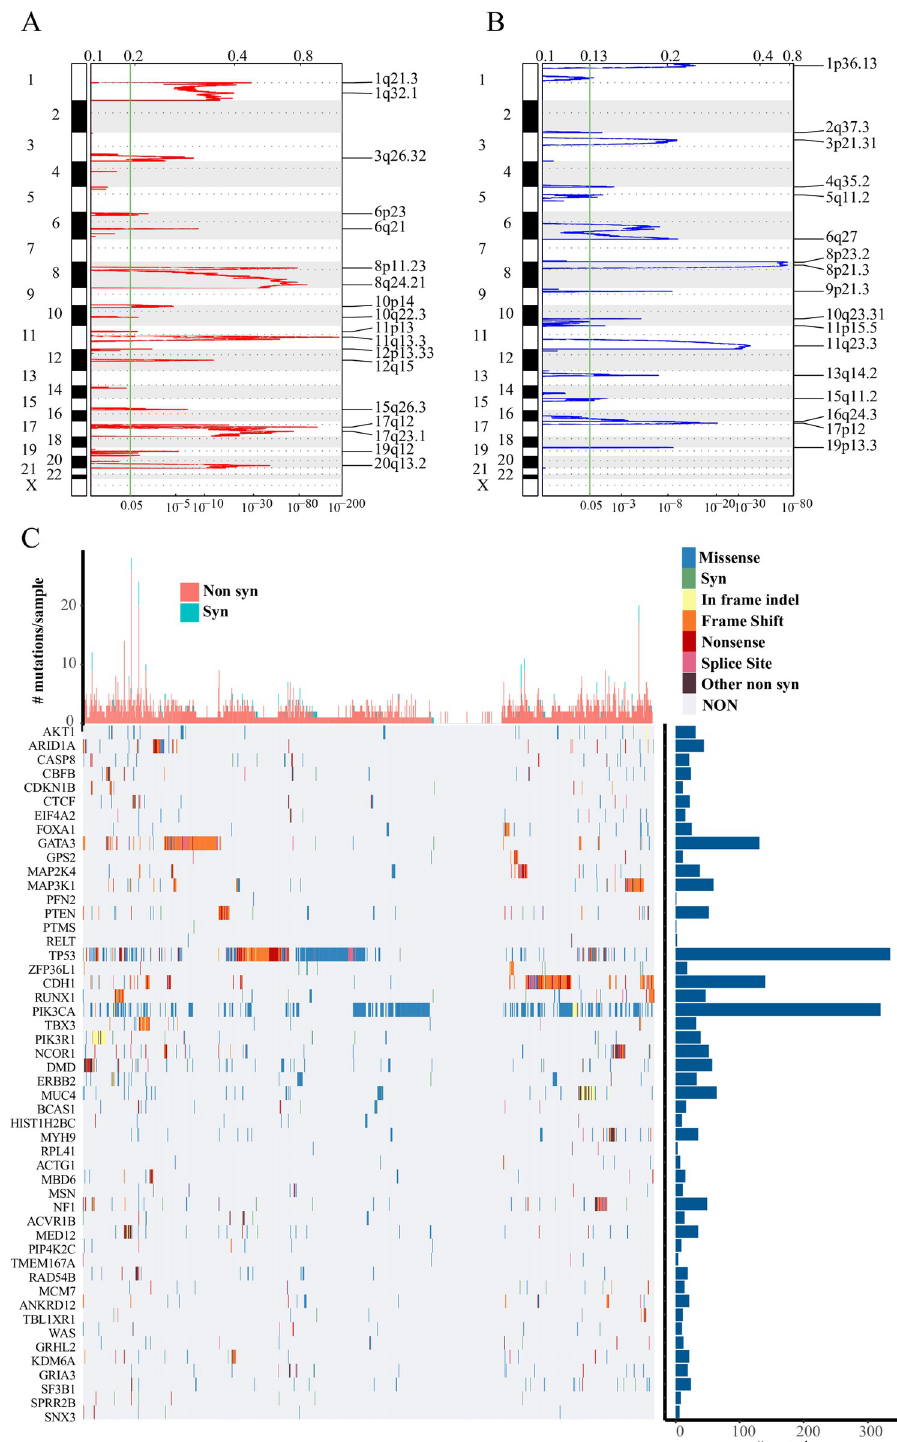
Fig 1. A: Significantly amplified fragments in the breast cancer genome. B: Significantly deleted fragments in the breast cancer genome. C: The distribution of the 50 most significant P genes in breast cancer patients, the top histogram shows the total number of synonymous and non-synonymous mutations in 50 genes per patient, and the right histogram shows the number of mutations in all the 50 genes. Different colors in the heat map indicate the type of mutation, and the gray color indicates no mutation.